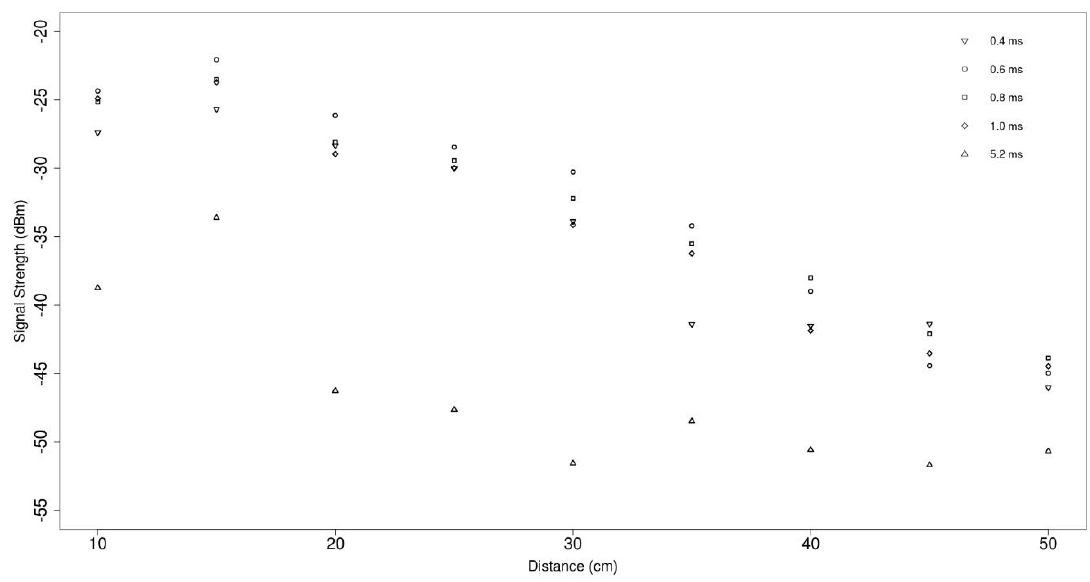
Figure 3. A graph showing the signal loss across distances with a range of conductivities.